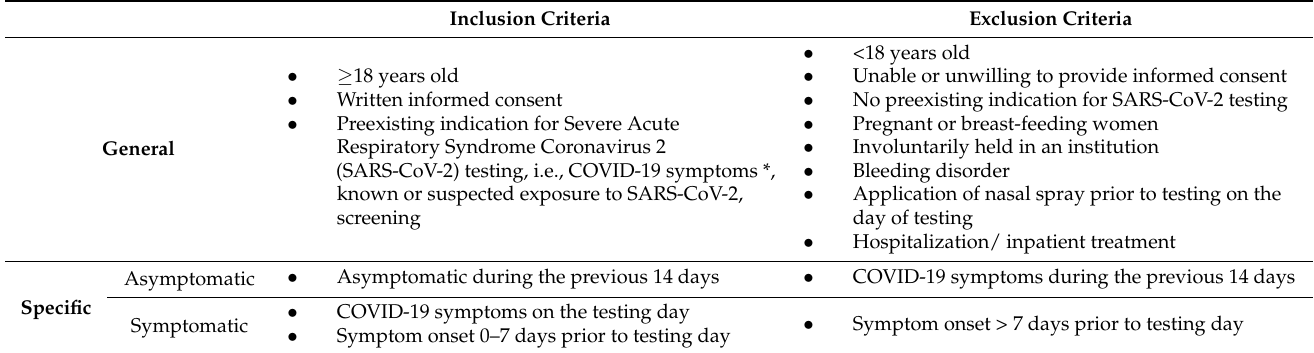
Table 1. Inclusion and exclusion criteria. General inclusion criteria apply for symptomatic as well as symptomatic participants, while specific inclusion criteria apply for the group stated. * Coronavirus disease 2019 (COVID-19) symptoms included fever, cough, sore throat, fatigue, general feeling of weakness, loss of smell or taste, shortness of breath, muscle stiffness, body aches, head cold, running nose, and others such as diarrhea or